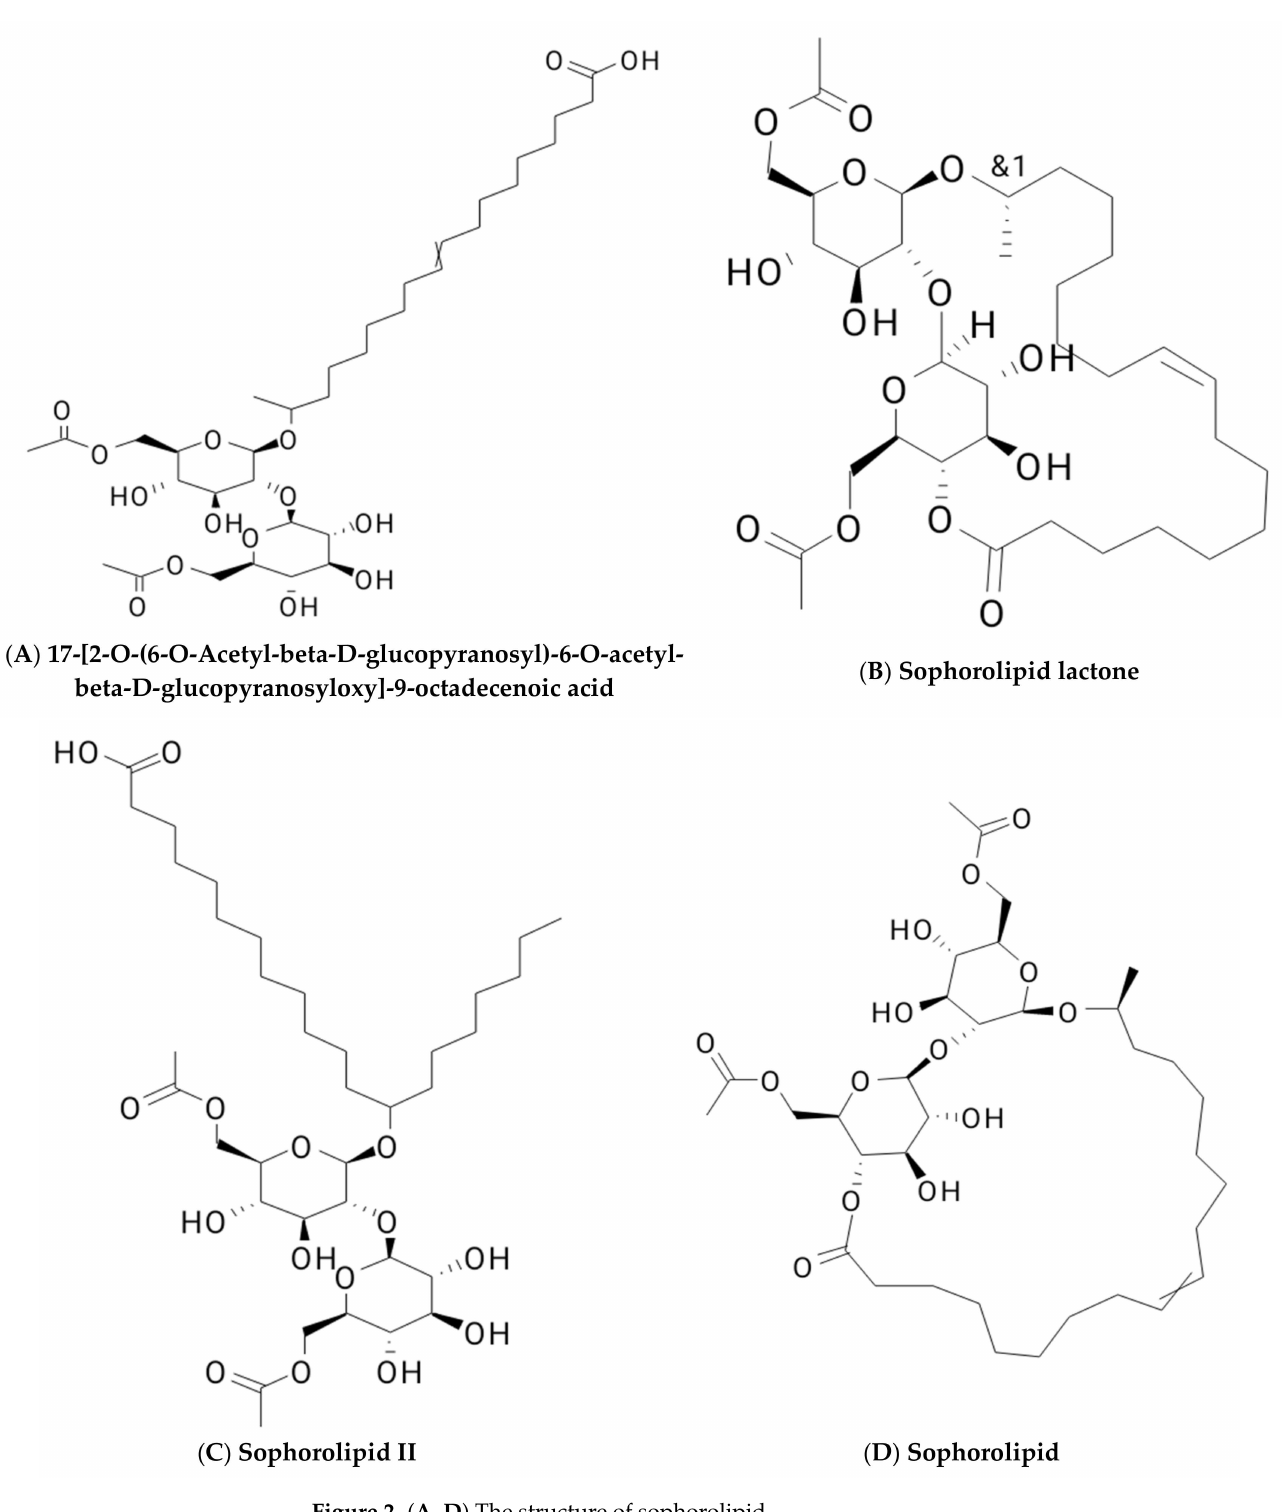
Figure 2. ( A – D ) The structure of